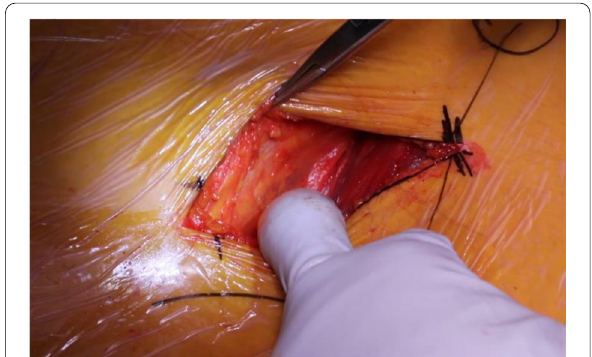
Fig. 2 Medial leaf of the fascia and blunt dissection